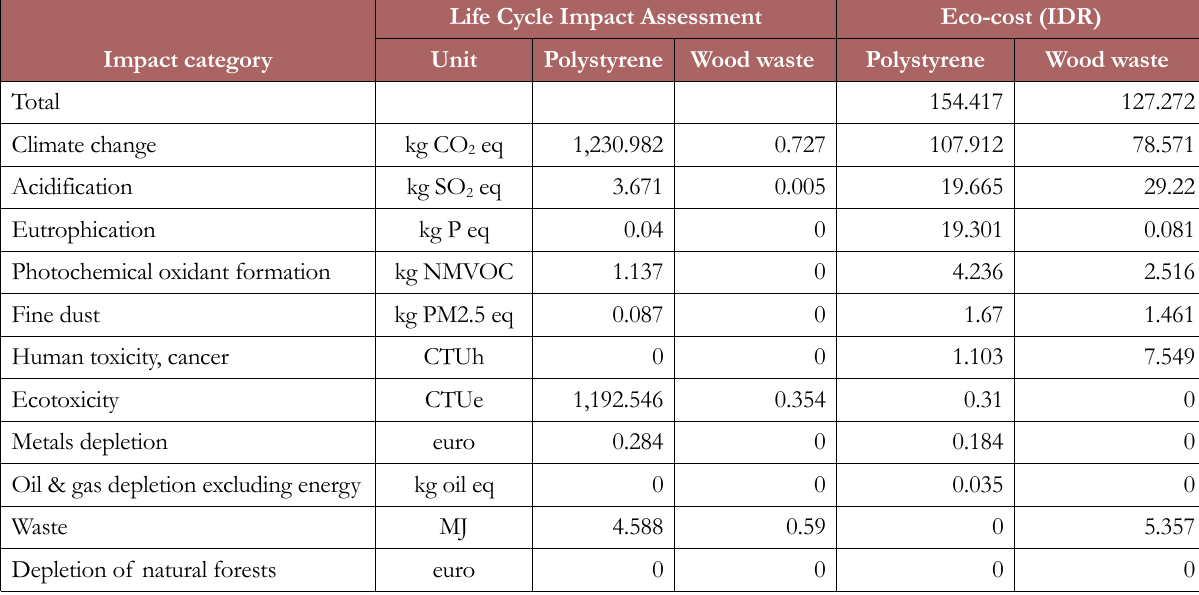
Table 4. The comparison of environmental